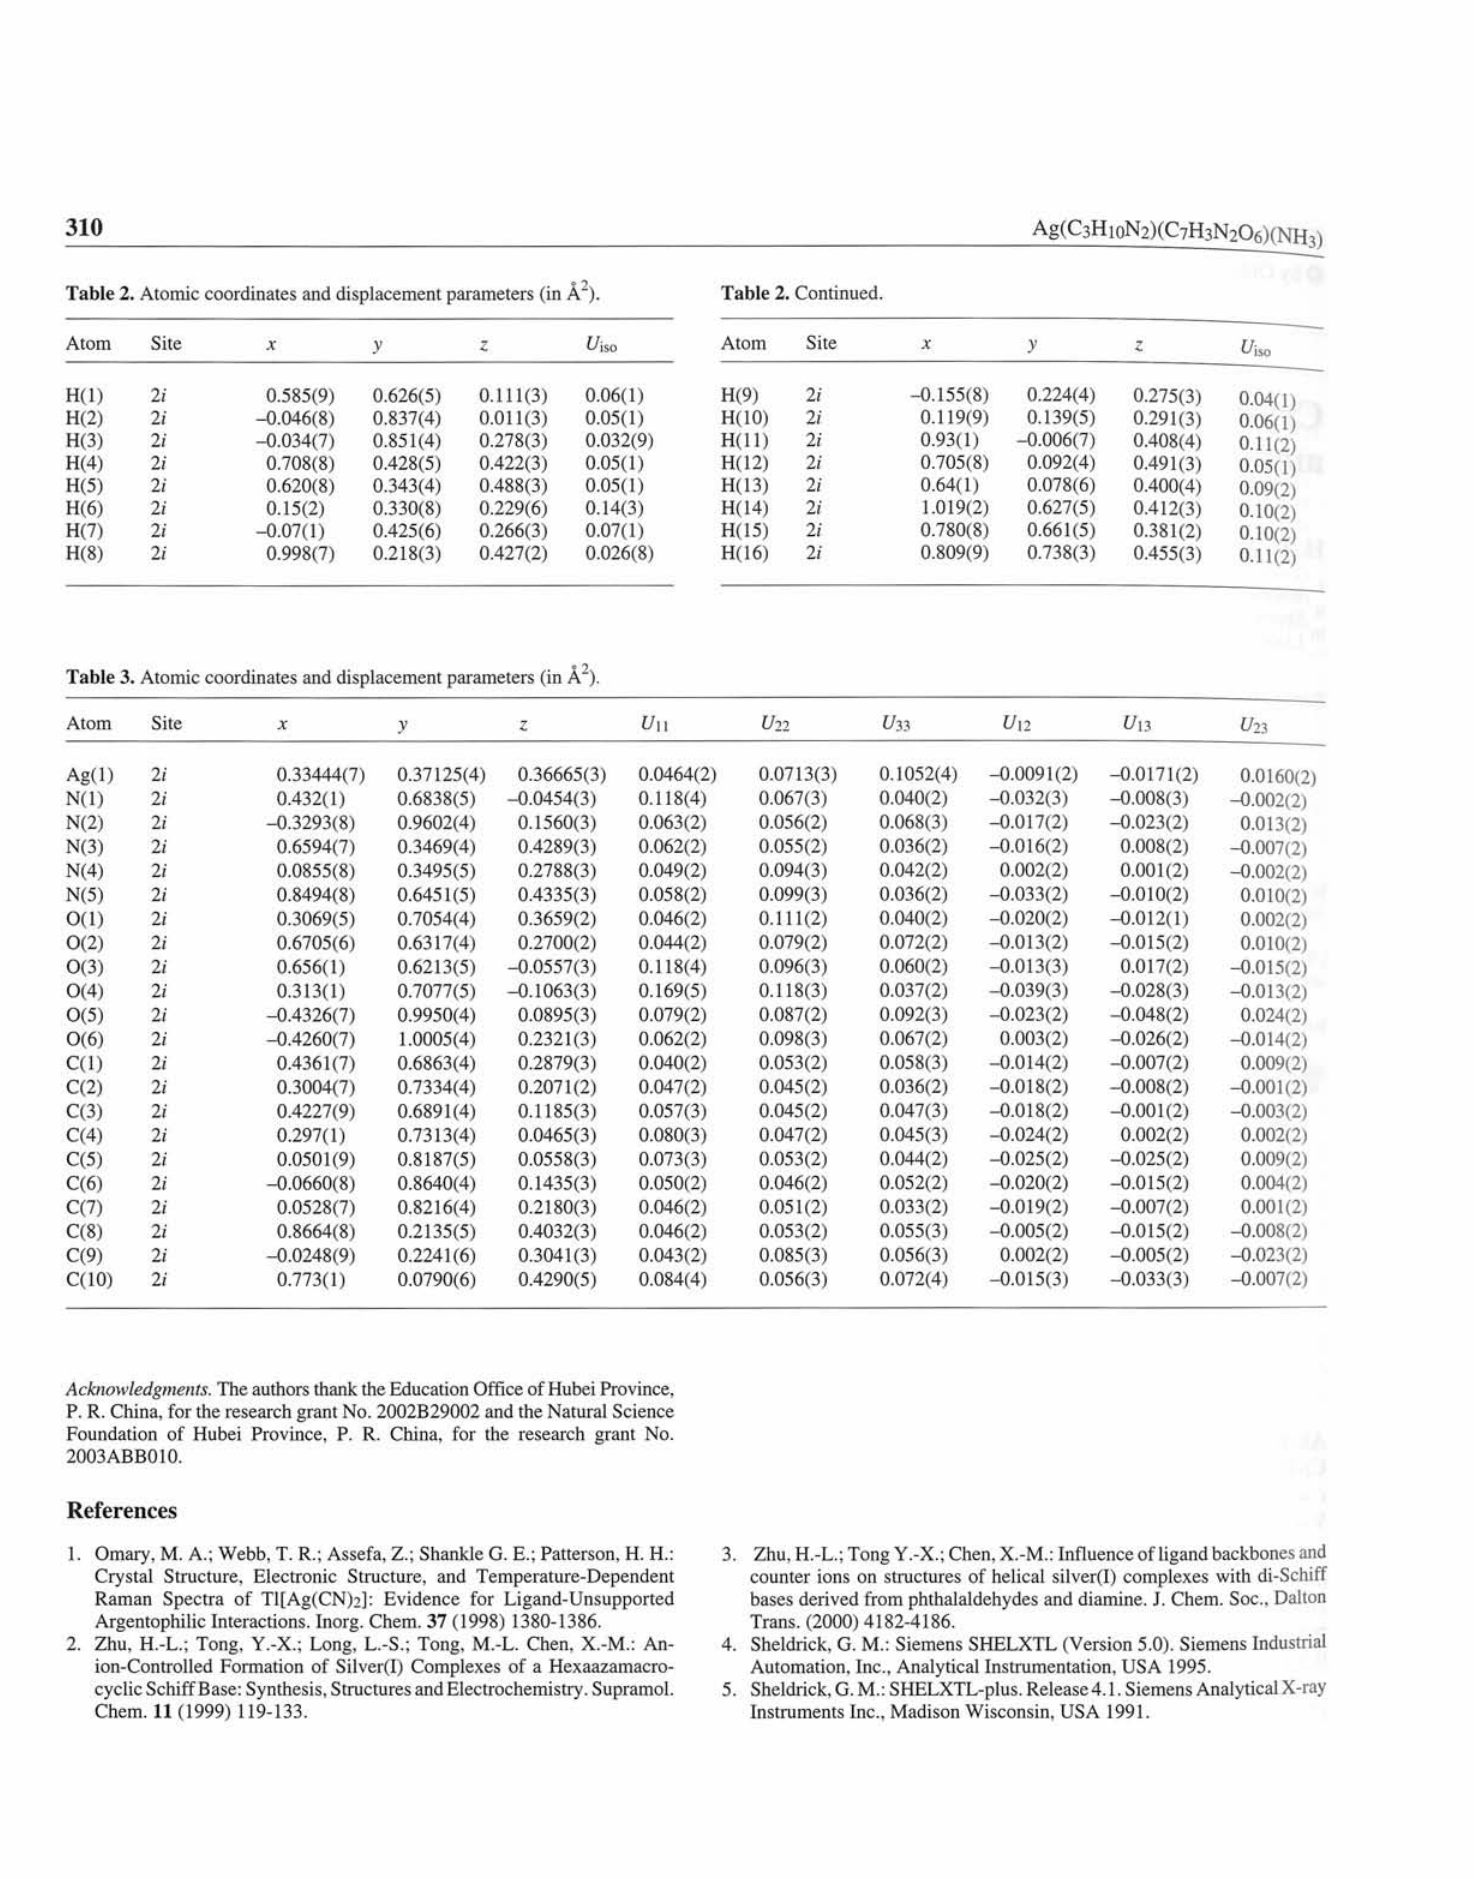
Table 2. Atomic coordinates and displacement parameters (in Á 2 ).